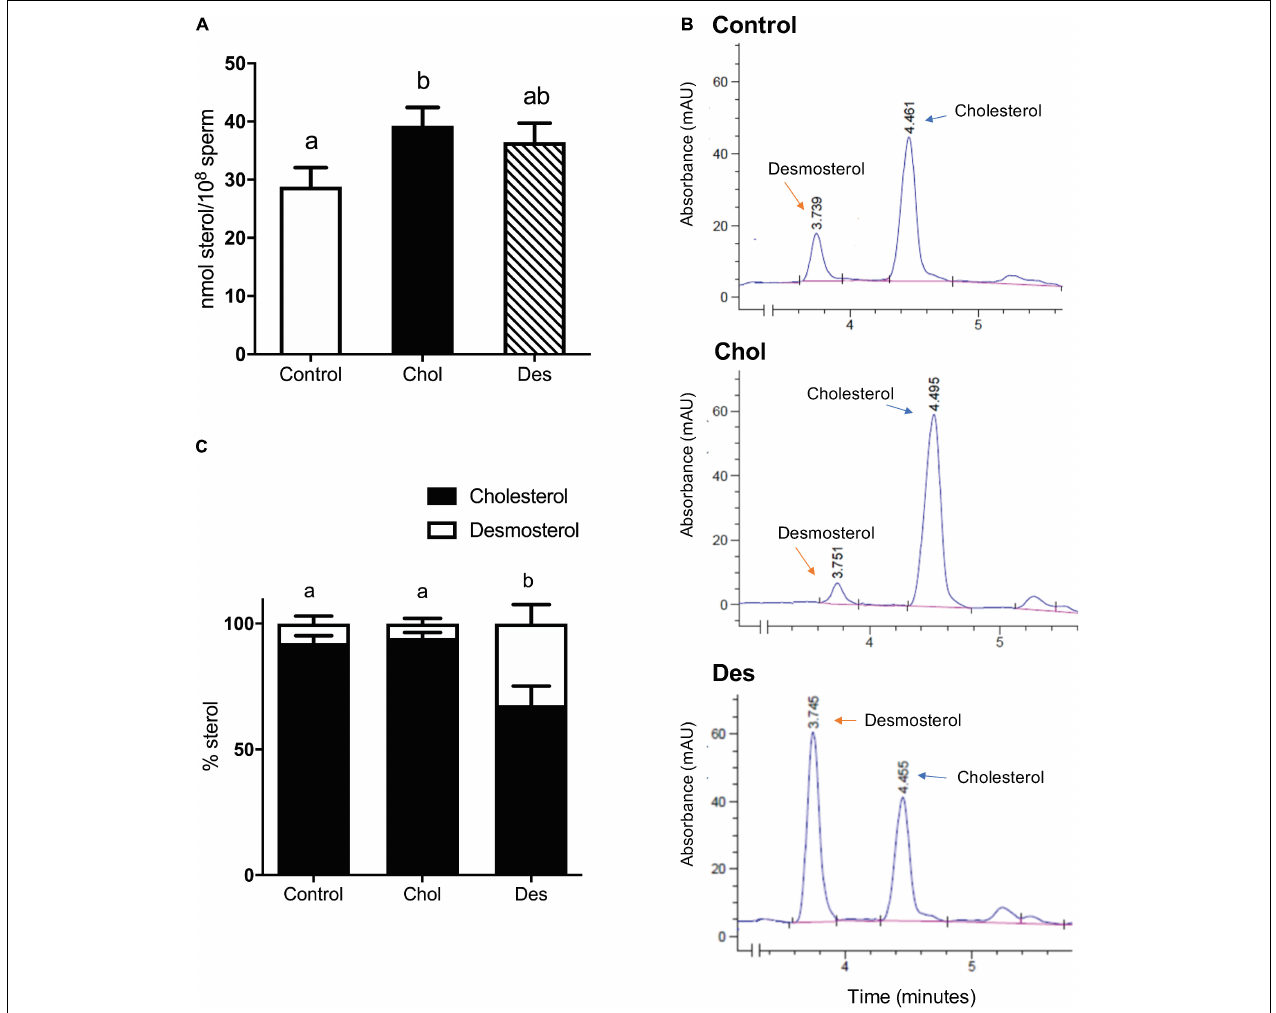
FIGURE 1 | Quantification of cholesterol and desmosterol in cryopreserved ram sperm pretreated with 10 mM M β CD-Chol (Chol) -Des (Des). (A) Effect of 10 mM M β CD-Chol or -Des pretreatment on total sterol content of frozen-thawed ram sperm. Results are expressed as nmol of sterols per 100 million sperm and represent mean values ± SEM of 7 (control y M β CD-Des) and 10 (M β CD-Chol) independent experiments. (B) Identification of cholesterol and desmosterol by HPLC in the ovine sperm sterol fraction of Control, Chol and Des groups. The peaks correspond to each sterol with the indicated retention times. (C) Quantification of cholesterol and desmosterol by HPLC in each experimental group. The results are expressed as percentage of sterols and represent the mean values ± SD of three independent measurements. Sterol content (%) among the experimental groups was compared by Generalized Linear Mixed Models (GLMM) with binomial distribution. The different letters (a, b) indicate significant differences ( p < 0.05). Data were analyzed by ANOVA and mean values were compared using the post hoc test LSD of Fisher. Different letters (a, b) indicate significant differences ( p <